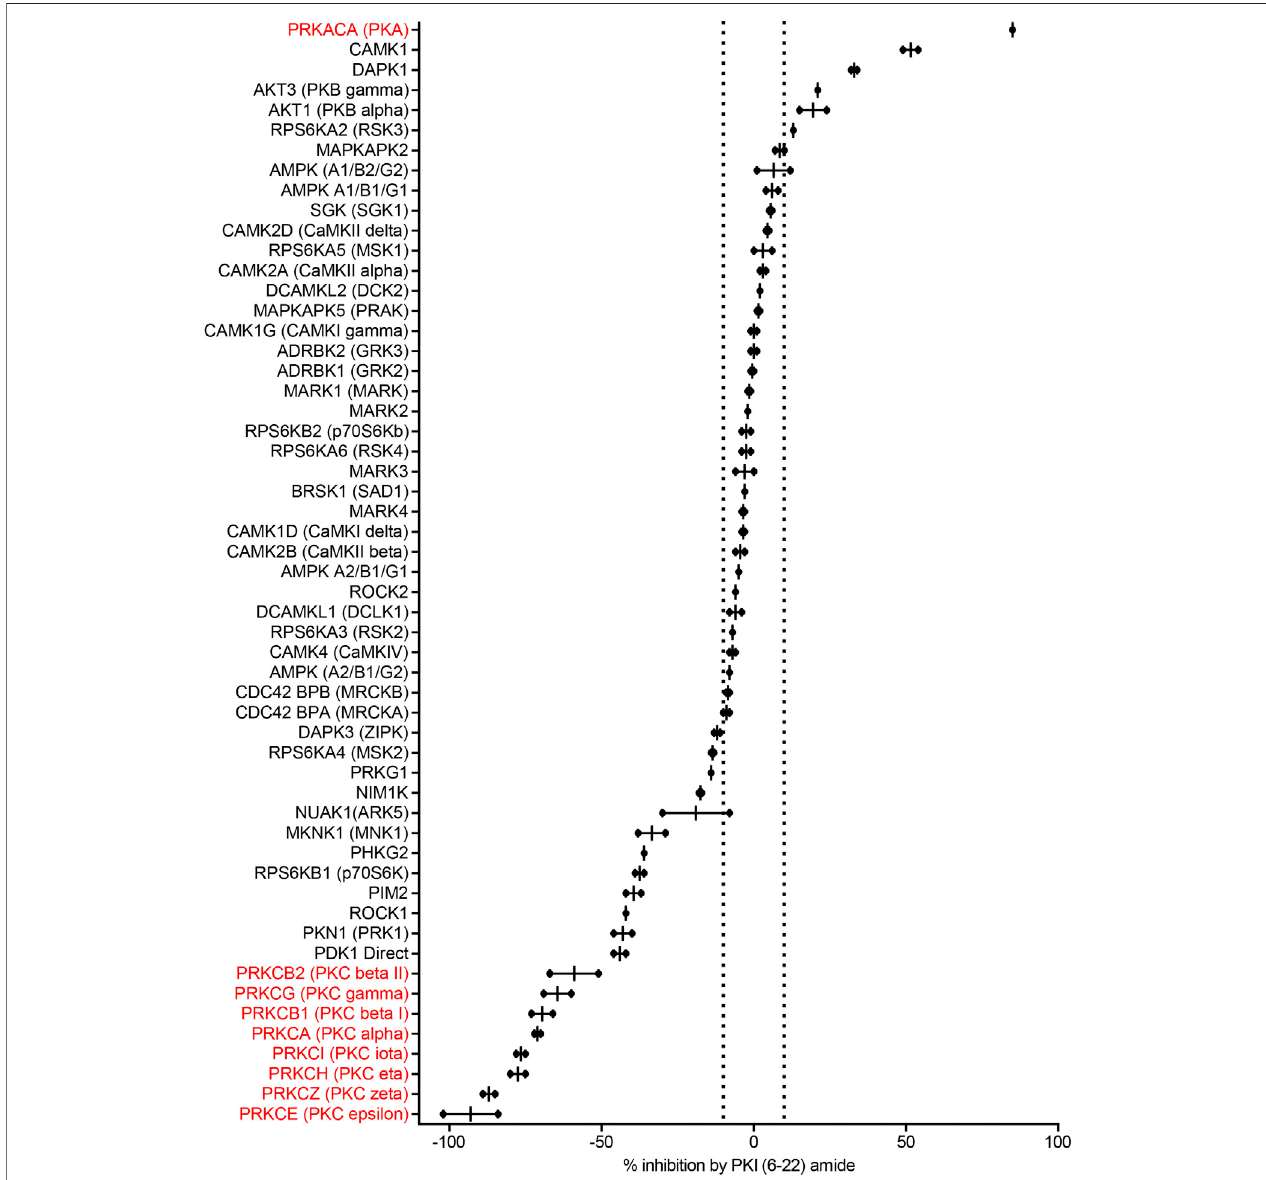
individual data points (aligned dots) and median with range